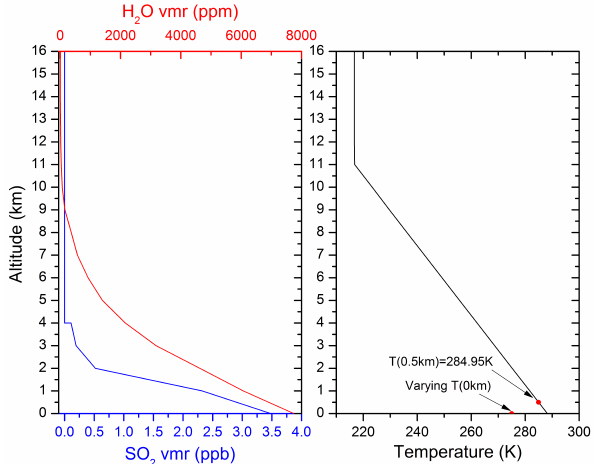
Figure 1. The 2-year average SO 2 vertical profile (ppb, blue) cal- culated from MOZART simulations (2009–2010), US Standard wa- ter vapour profile (ppm, red) and temperature (K, right panel). The SO 2 profile shown here corresponds to a 0–4km column of SO 2 of 0.4DU. The thermal contrast is defined as the difference between the surface temperature and the temperature of the air at 500m (red